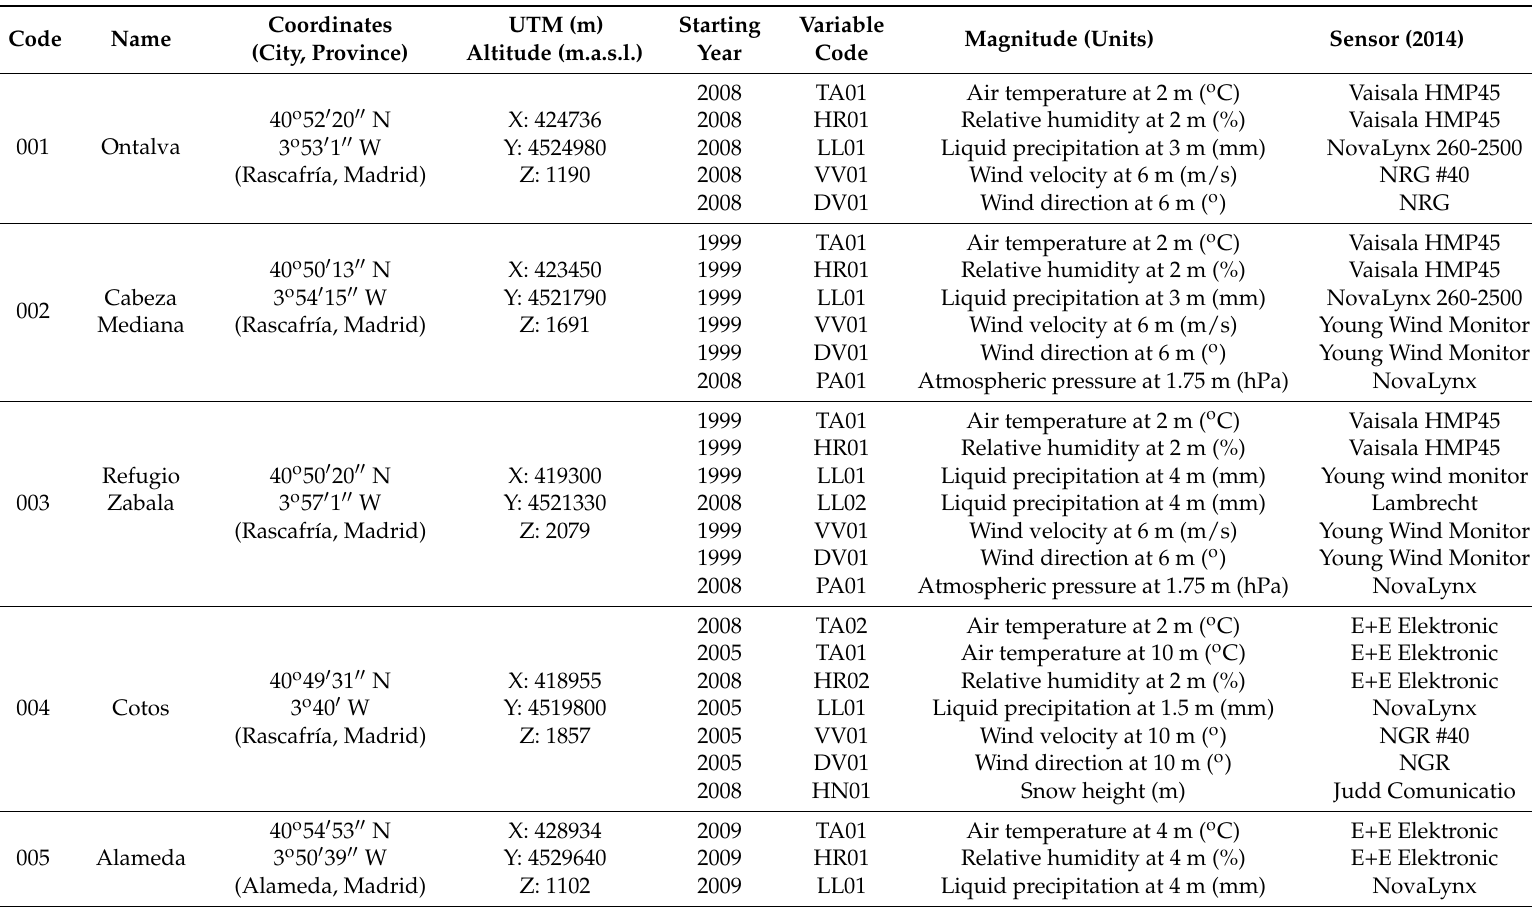
Table 3. Description of the location and characteristics of the observing sites of Peñalara Meteorological Network. Instrumentation has changed since first installation but last one is included in this